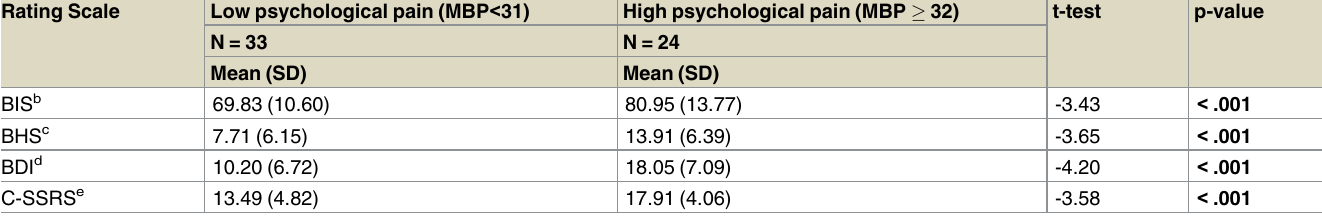
MBP scores in suicidal vs major depressive episode (MDE) patients We compared MBP scores from suicidal patients and the cohort of MDE patients from our earlier study[5]. A post-hoc t-test showed no significant difference in means between the groups: (mean MBP .30.14 ± 7.82,) and MDE (mean MBP 28.7 ± 6.4); t = -1.21, suicide MDE p = .23). Table 4. Two-tailed ‘t’ tests showing significant differences in test scores between high and low scoring patients on the MBP a . Rating